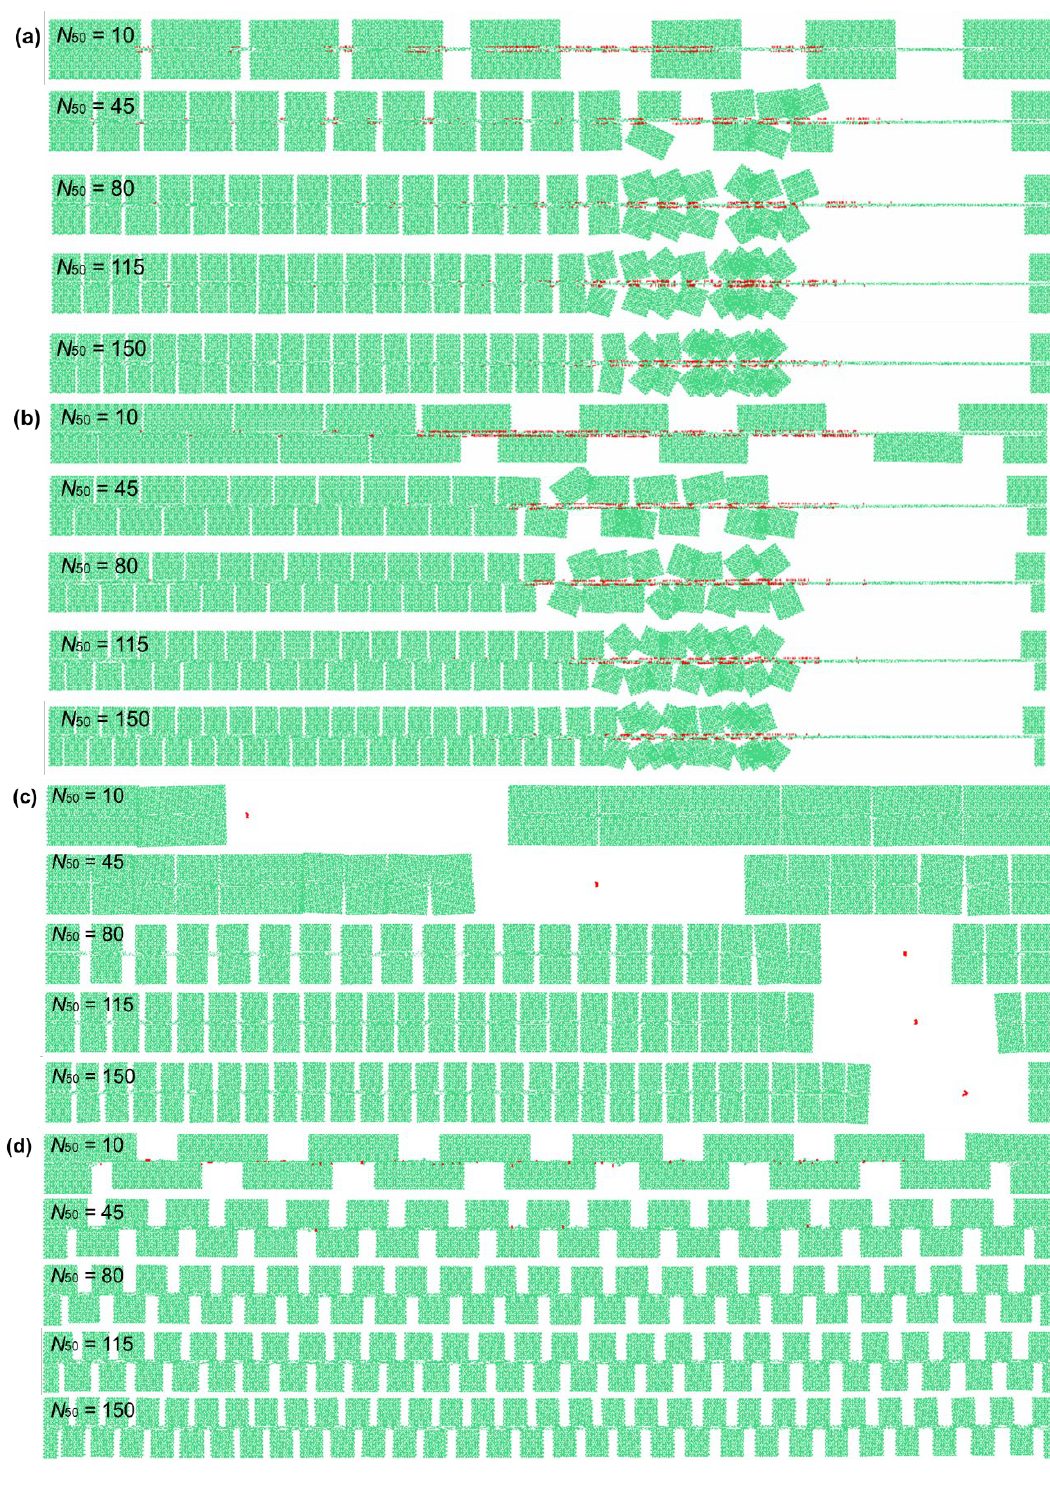
Fig. 5: Numerical observations of MTCT